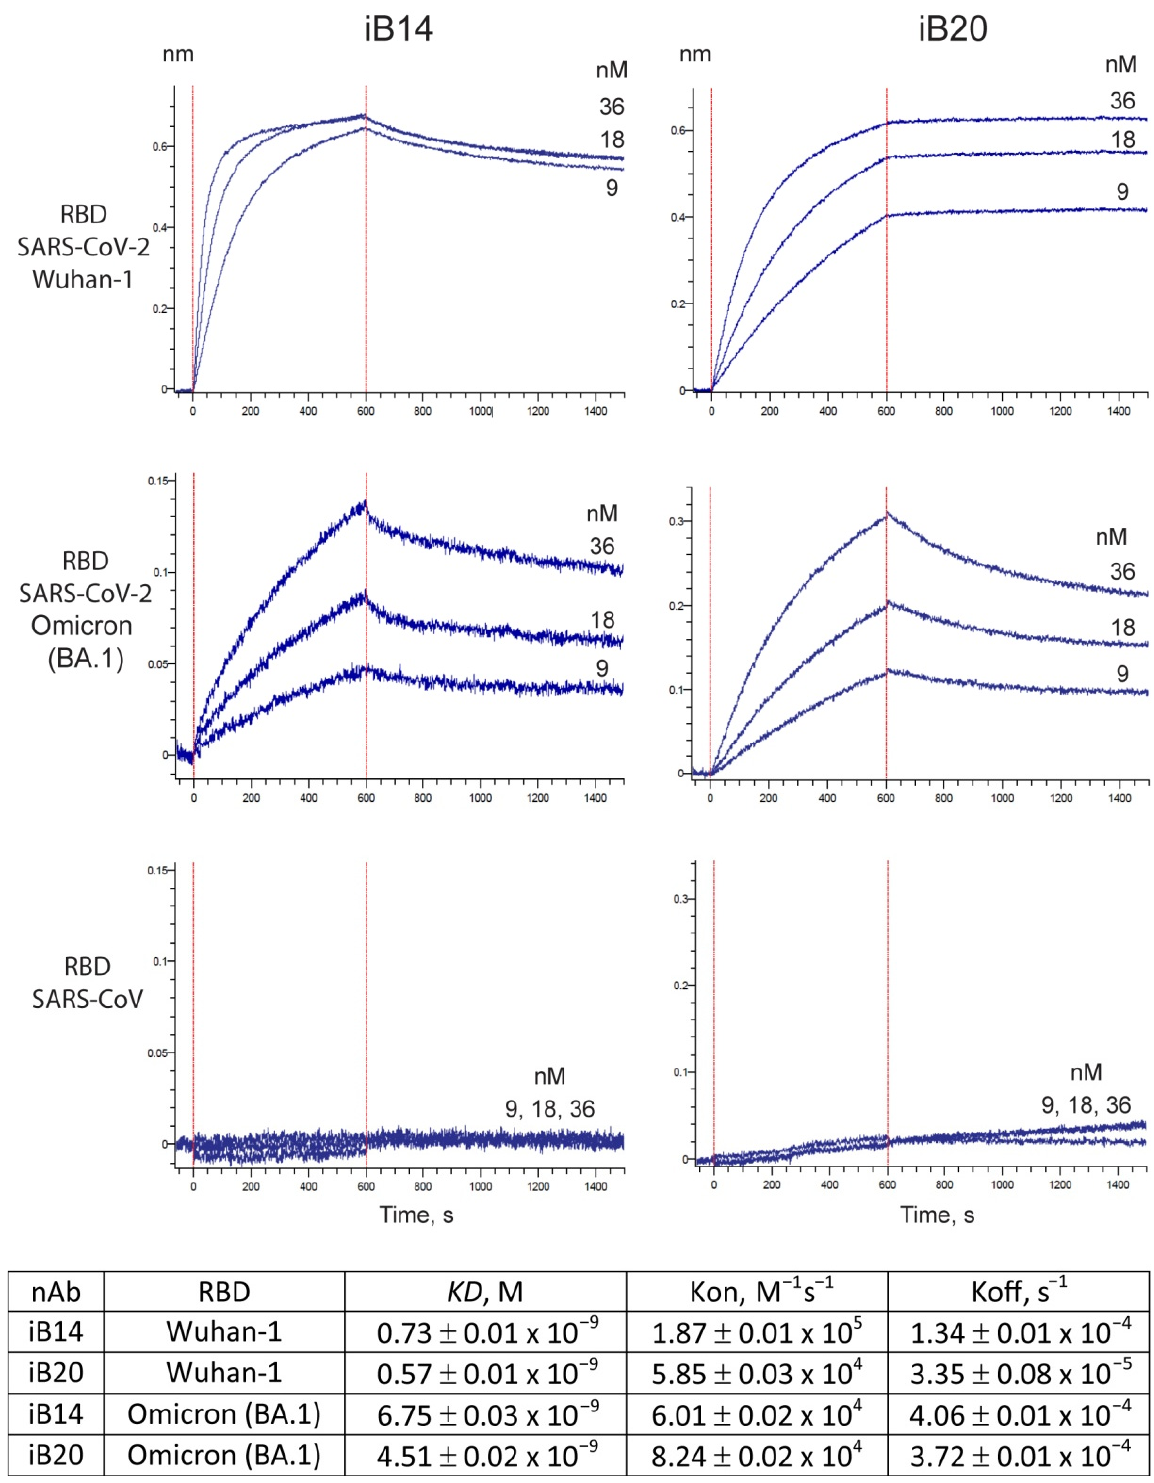
Figure 1. BLI analysis of the interaction between nAbs iB14 and iB20 (9 ‐ 36 nM) with the indicated RBDs of SARS ‐ CoV ‐ 2 and SARS ‐ CoV.